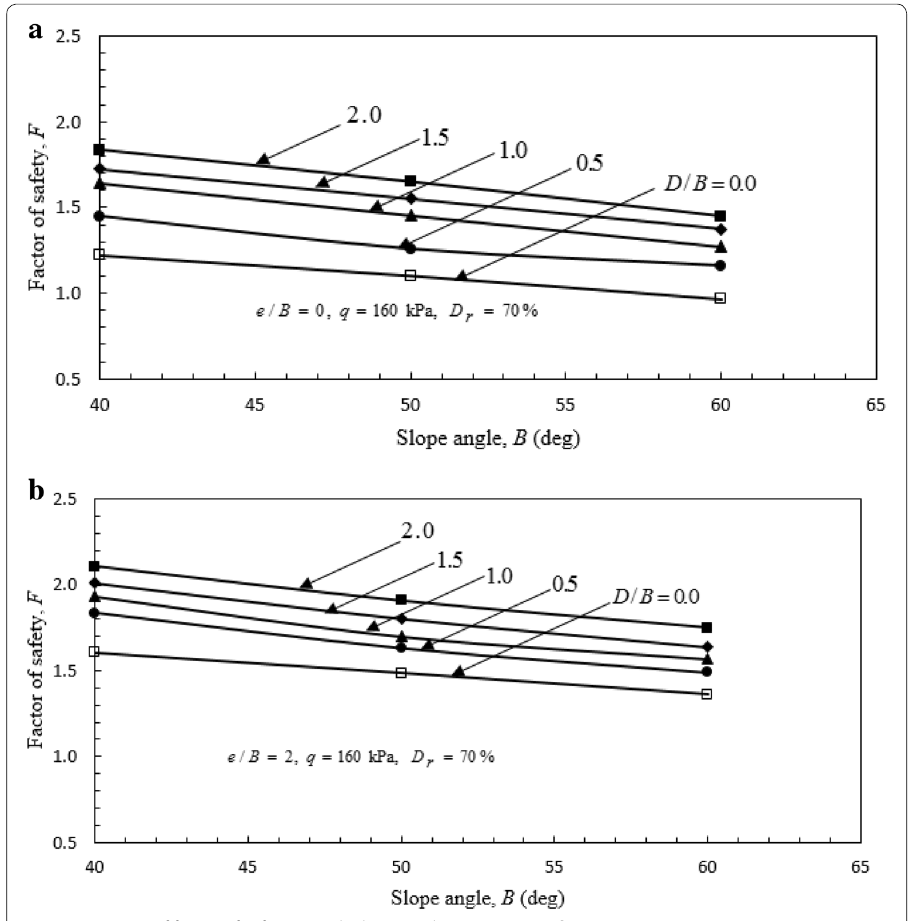
Fig. 9 Variation of factor of safety, F , with slope angle, β : a e / B = 0 , b e / B =